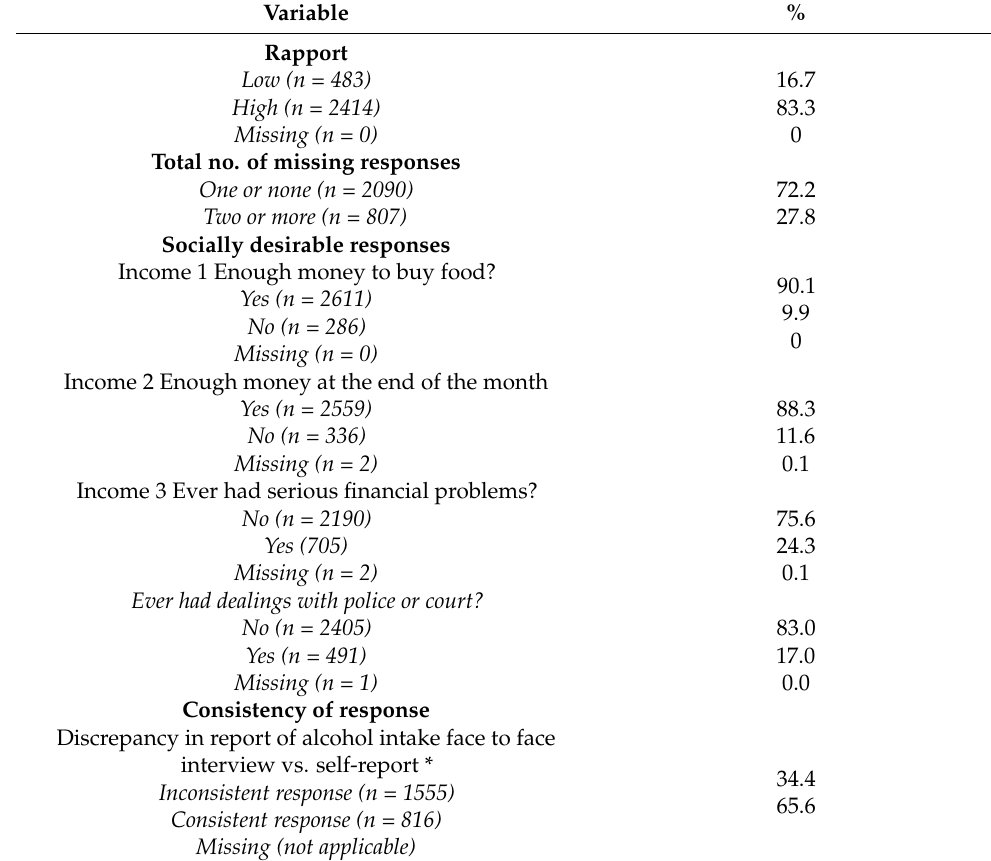
Table 2. Distribution of dependent and outcome variables.